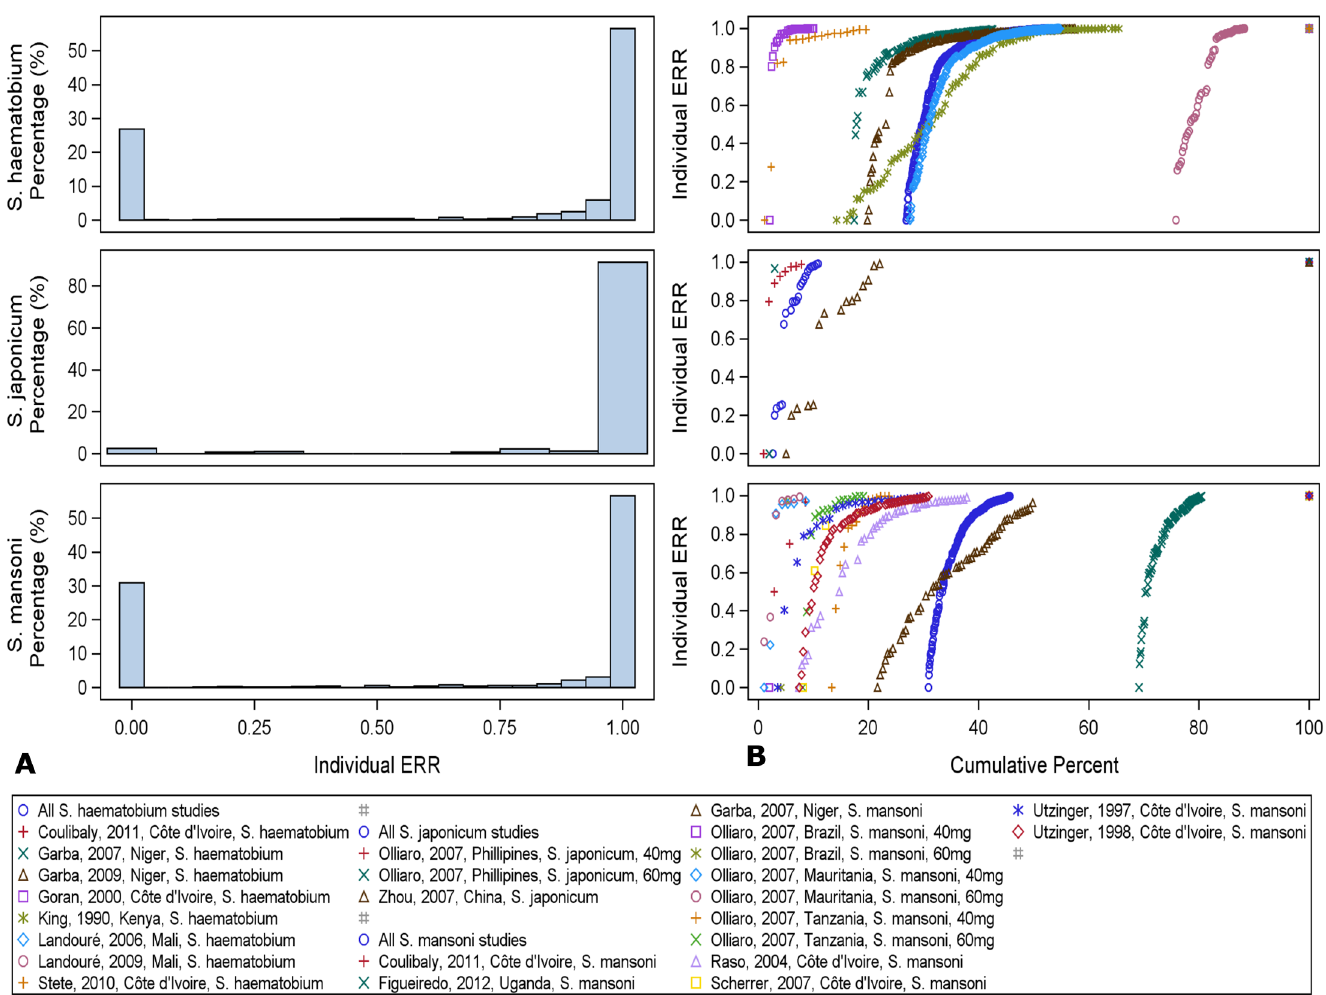
Fig 3. Distribution of individual ERR. A. Bar diagrams, B. Centile